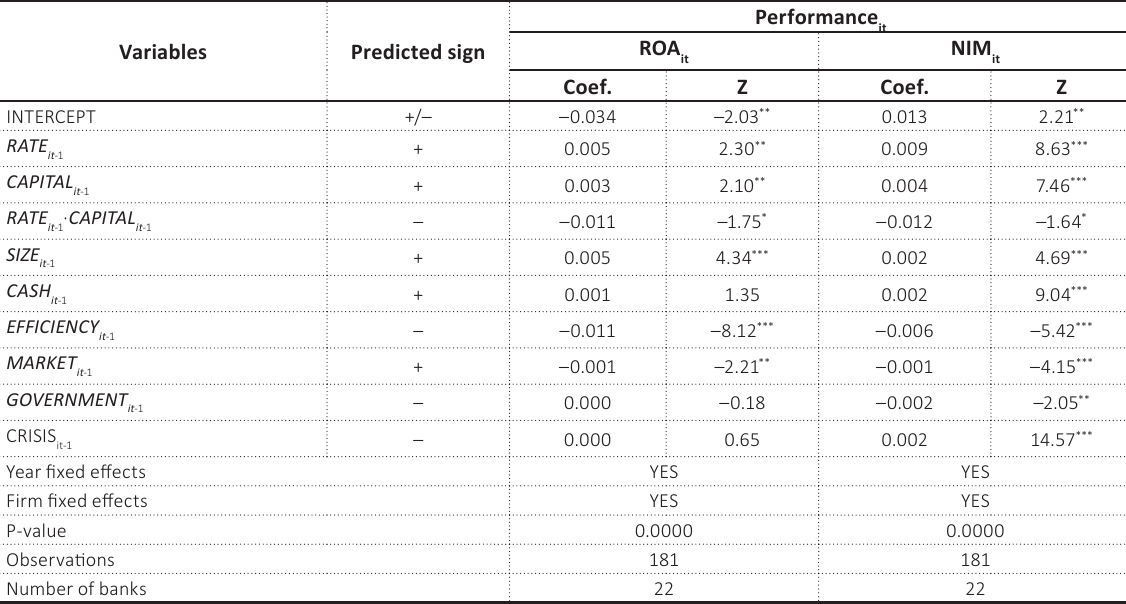
Table 2. Main results using cross-sectional time-series Generalized Least Squares regression –